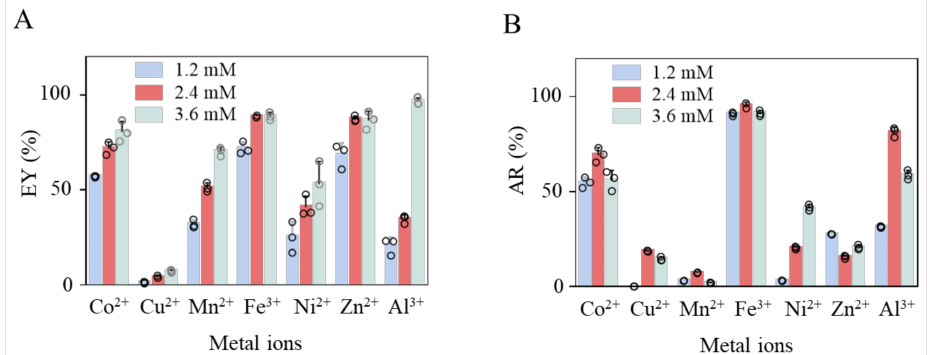
Figure 2. Effects of metal ions on EY ( A ) and AR ( B ) of immobilized